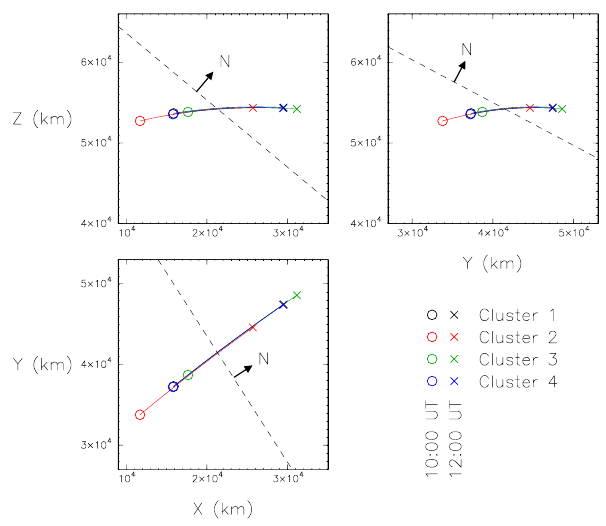
Fig. 1. The Cluster orbit traces from 10:00 UT (marked by cir- cles) to 12:00 UT (crosses) on the 25th January 2002, in the GSE Z − X (top left), Z − Y (top right) and Y − X (bottom left) planes. The traces are plotted in the standard Cluster colours shown in the key. As this interval occurred during a period of spacecraft manoeuvres, the spacecraft were oriented in a string formation as they crossed the magnetopause (between 10:41 and 11:12 UT), rather than a tetrahe- dron. The normal vector ˆ N derived in Sect. 2.5 has also been pro- jected into the plane of each panel, along with the corresponding magnetopause